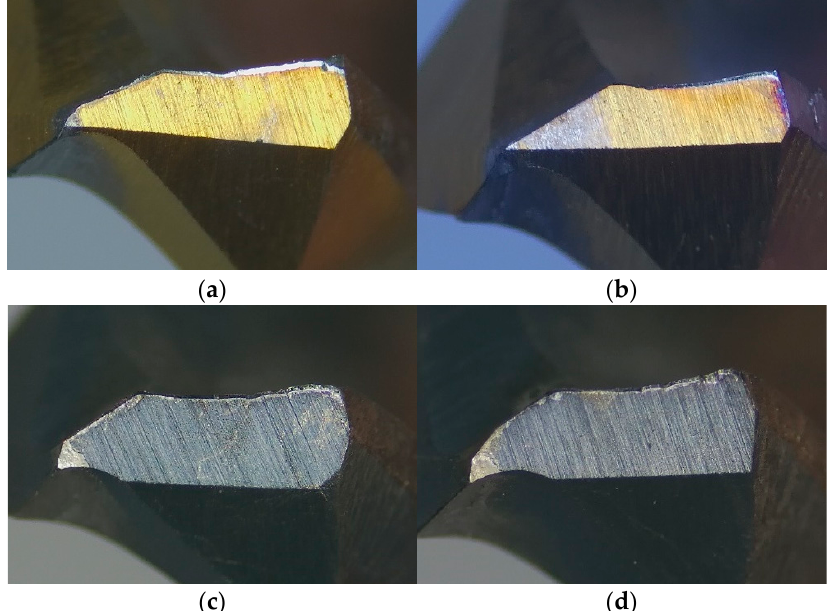
Figure 7. Wear locations for different coated drills used. ( a ) TiN-coated drill in speed of 15 m/min (after drilling 50 holes). ( b ) TiN-coated drill in speed of 20 m/min (after drilling 30 holes). ( c ) AlTiN-coated drill in speed of 15 m/min (after drilling 55 holes). ( d ) AlTiN-coated drill in speed of 20 m/min (after drilling 45 holes).